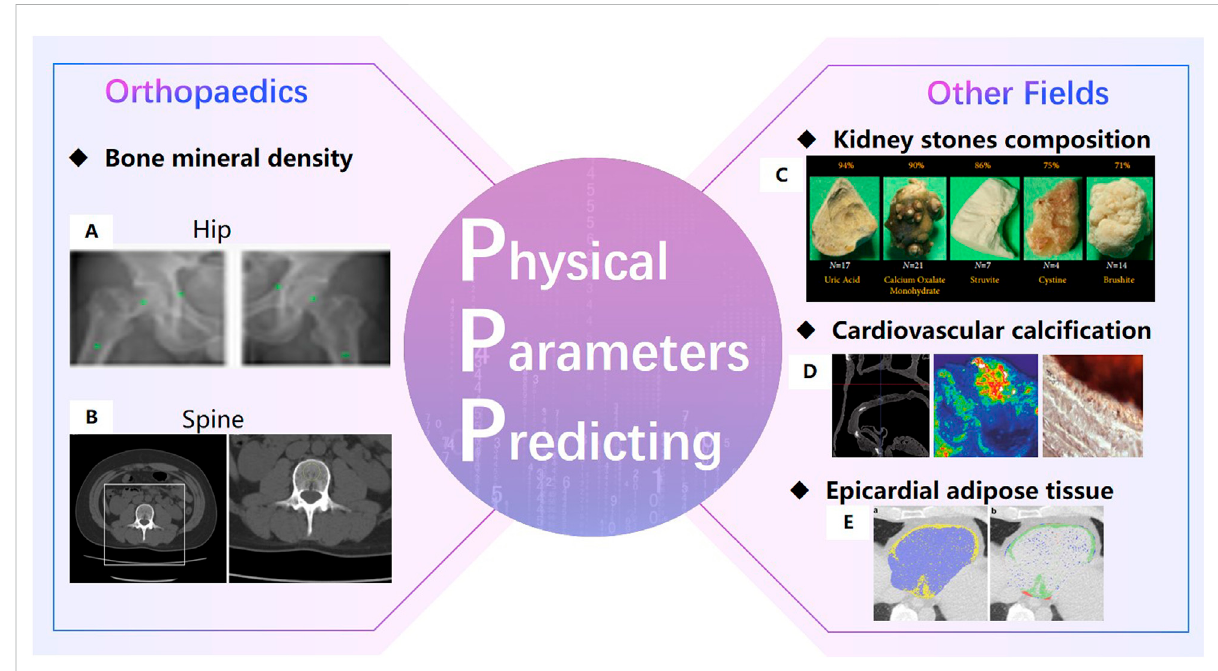
FIGURE 5 Physical Parameters Predicting (Hsieh et al., 2021). (A) . Bone mineral density prediction of hip (Yasaka et al., 2020). (B) . Bone mineral density prediction of lumbar spine. (C) automatically detect kidney stones composition (Black et al., 2020). (D) . cardiovascular calci fi cation (Dhivya et al., 2015). (E) . Epicardial adipose tissue prediction (Molnar et al.,